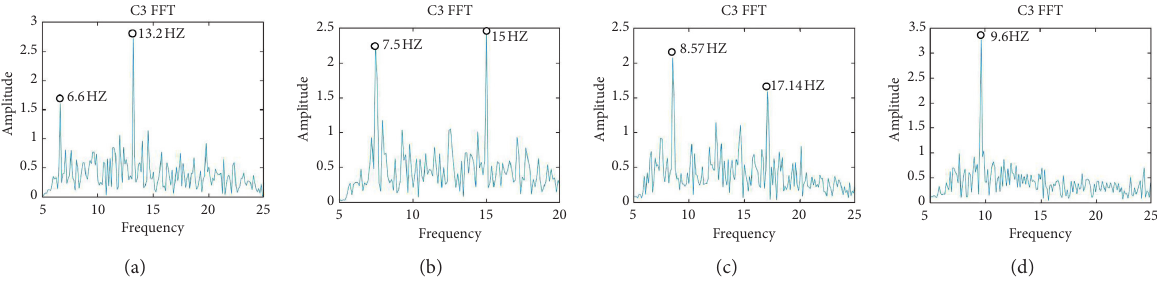
Figure 6: The frequency feature and the second harmonic frequency feature for results of the different SSVEP stimulation: (a) 6.6Hz flicker, (b) 7.5 Hz flicker, (c) 8.57Hz flicker, and (d) 9.6Hz flicker.